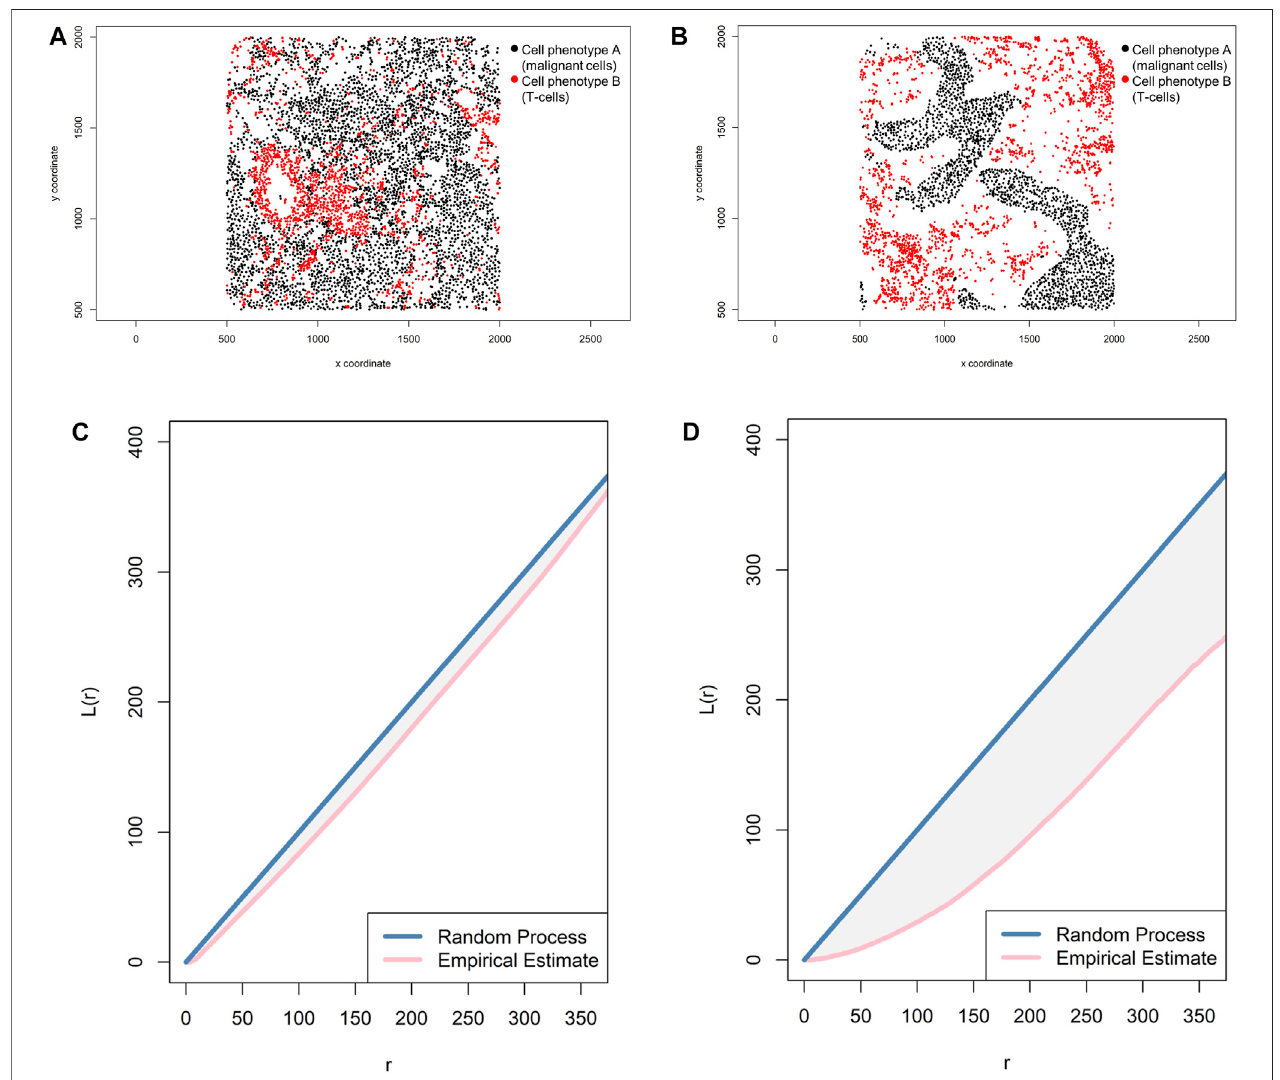
FIGURE 12 | Representative graphs showing the L-function [L( r )] for two different cellular distribution patterns between two group of cells from a representative point pattern in multiplex immuno fl uorescence images of lung adenocarcinoma. (A) Random point pattern distribution of cell phenotype A and B. (C) Graphic representation ofthe L( r ) lineshowing its proximity to the theoretical estimate (Poisson line), characterizing a random or mixed pattern of one cell phenotype inrelation to anothercellphenotype. (B) UnmixedpointpatterndistributionofcellphenotypeAandB. (D) GraphicrepresentationoftheL( r )lineshowingthatitislocatedfarfrom the theoretical estimate (Poisson line), characterizing a clustering or unmixed pattern of one cell phenotype in relation to another cell phenotype. The graphics were generated using R studio software version